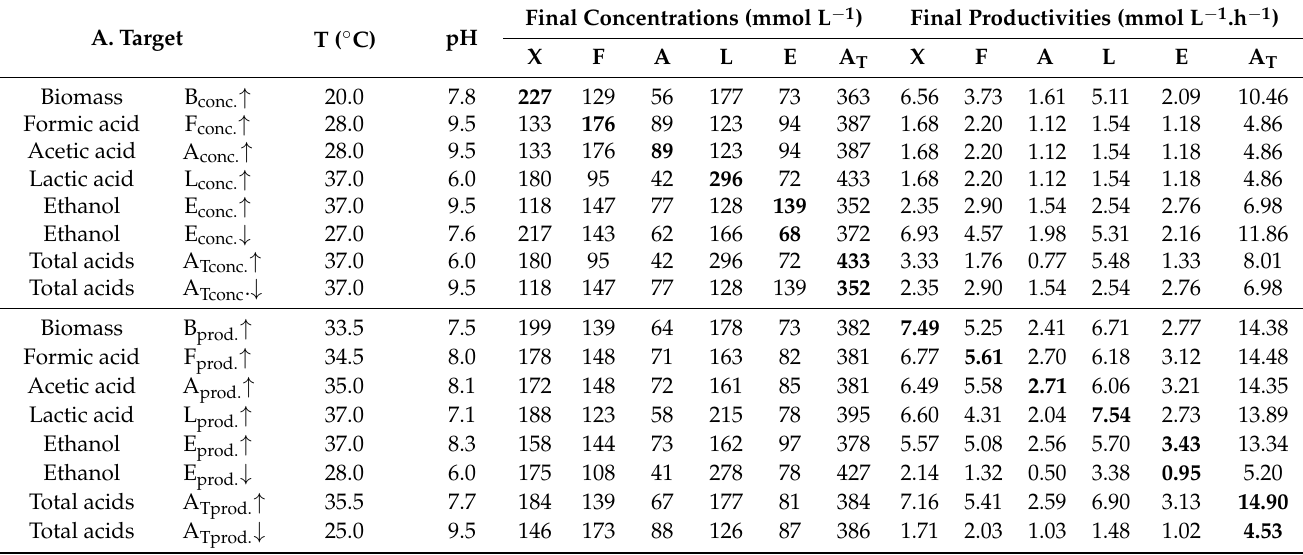
Table 3. Optimal conditions for growth and production of metabolites according to the developed model. In bold : targeted metabolite for each set of operating conditions. Final concentrations and productivities calculated with initial